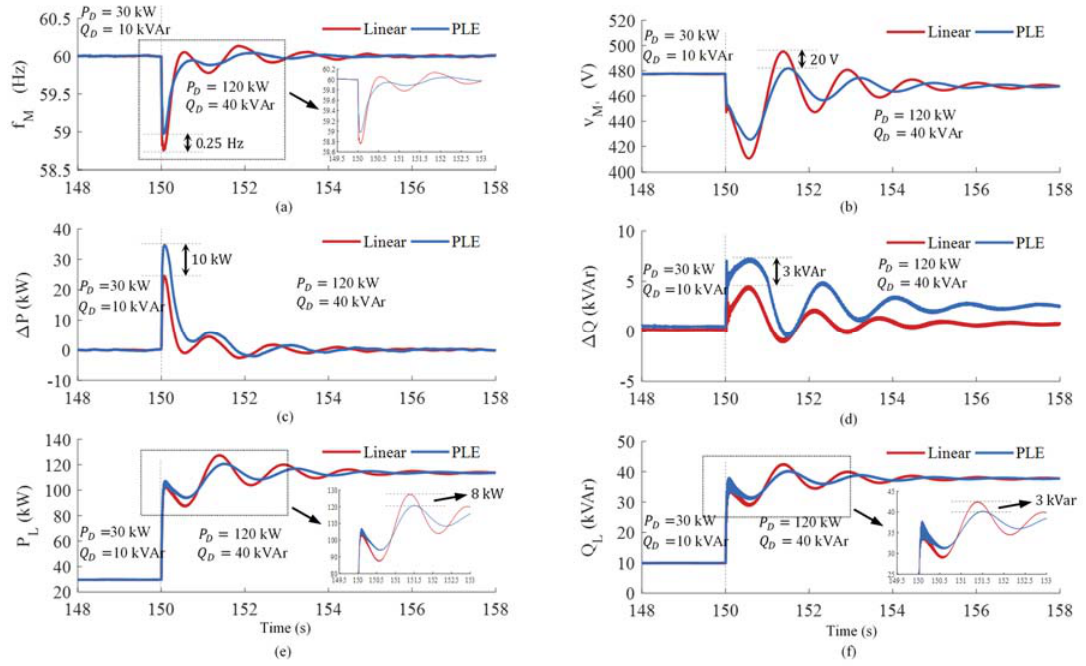
Figure 7. Comparing the performance of linear and PLE droops in a dynamic-response enhancement of the system during a step change in load demand: ( a ) AC-bus frequency; ( b ) AC-bus voltage; ( c ) BESS active power; ( d ) BESS reactive power; ( e ) load active power; and ( f ) load reactive power. Table 2. Dynamic performance comparison of linear and PLE droops for a step change in load demand. With Linear With PLE